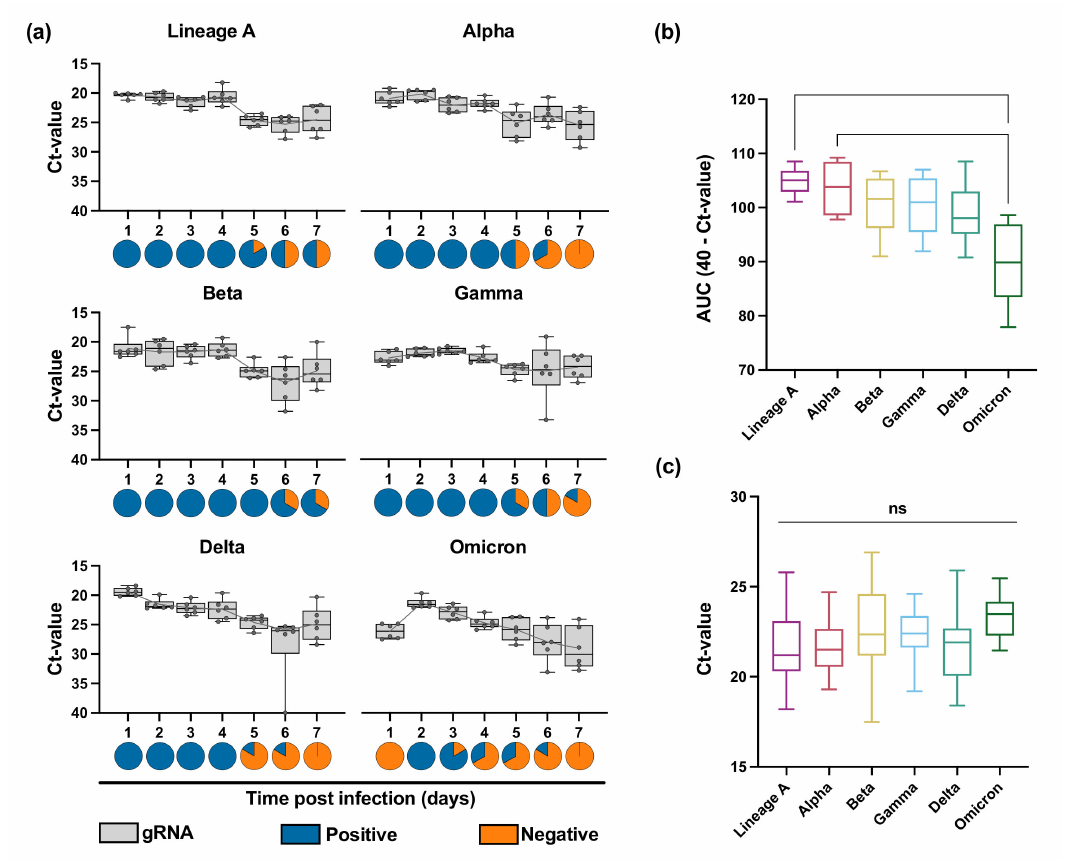
Figure 2. InteliSwab ™ results for SARS-CoV-2 variants in Syrian golden hamsters. For each variant, animals (N = 6) were inoculated with 1 × 10 3 TCID 50 /mL. Oropharyngeal swabs were taken for 7 days. ( a ) Box plots depicting viral load (gRNA) in swabs across the 7 days; box and whiskers represent the median, minimum, maximum, and individual Ct values. Gray lines represent the mean Ct value of oropharyngeal swabs for each day. Pie charts show results of oropharyngeal swabs tested by InteliSwab ™ ; blue = positive; orange = negative. For b and c, statistical significance was measured by the Kruskal–Wallis test. ( b ) Box plots showing cumulative (area under the curve (AUC) analysis) respiratory shedding of SARS-CoV-2 variants viral load in oropharyngeal swabs measured by gRNA. Box and whiskers represent the median, minimum, and maximum cumulative respiratory